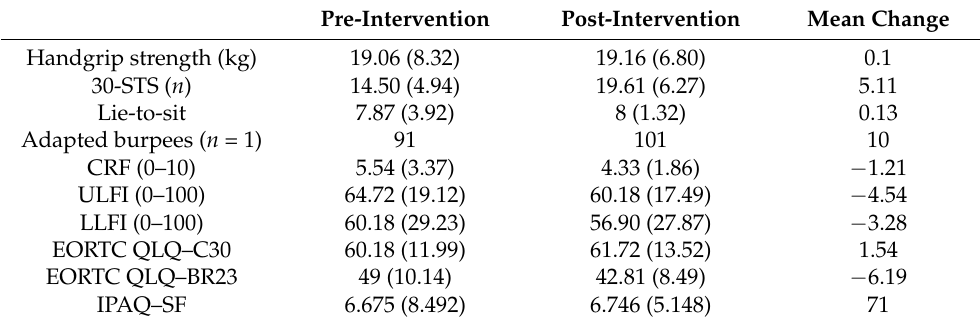
Table 4. Patients’ functional and self-reported outcomes from intervention group ( n =